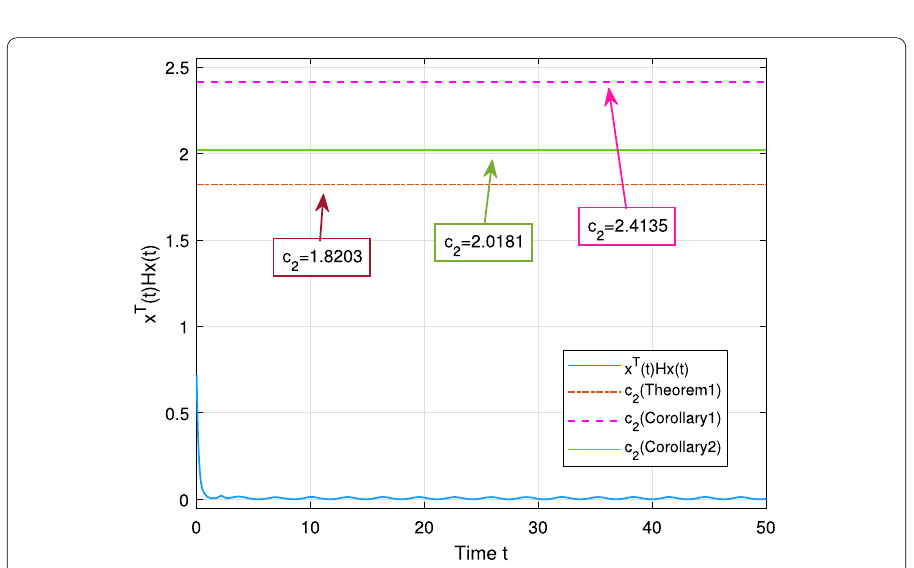
Figure 3 Time history of x T ( t ) Hx ( t ) for the GNNs (9) in Case I Example 4.1, T = 50